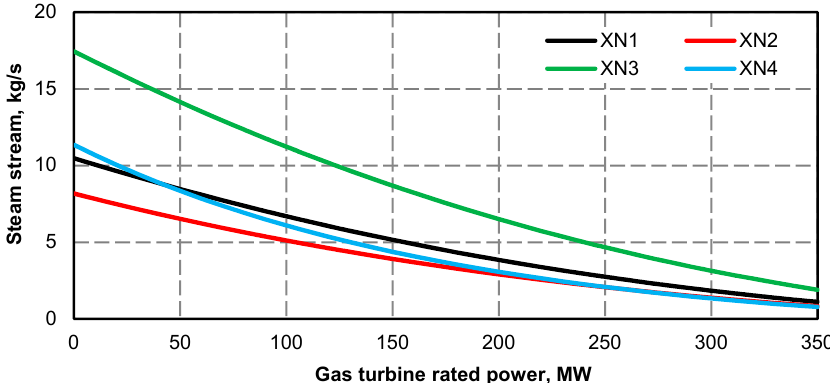
Figure 30. The streams of extraction steam for the XN1–XN4 low-pressure regeneration exchangers for a maximum fixed stream of 319.4 kg/s fresh steam fed to the steam turbine as a function of gas turbine power.